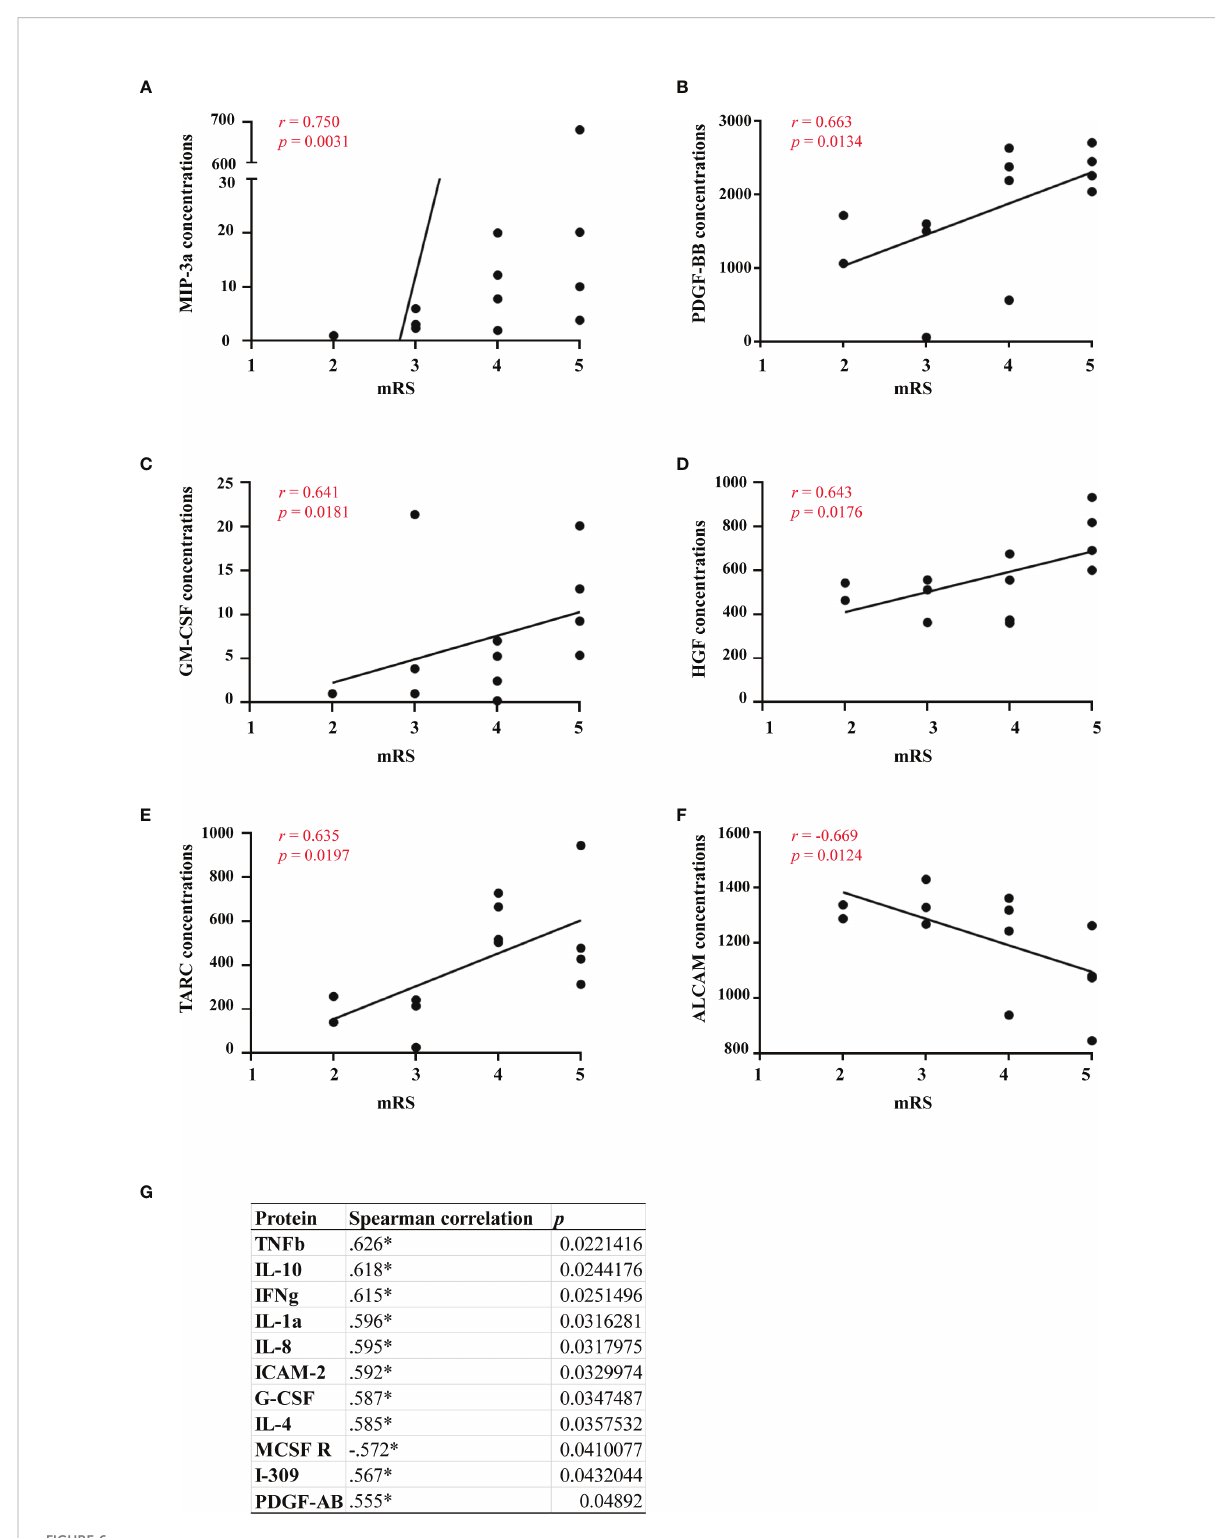
FIGURE 6 Relationships between serum cytokines and clinical severity. Correlations between clinical severity and serum levels of MIP-3a, PDGF-BB, GM- CSF, HGF, TARC, ALCAM and other proteins were analyzed by spearman ’ s rank analysis and were showed in (A – G) .